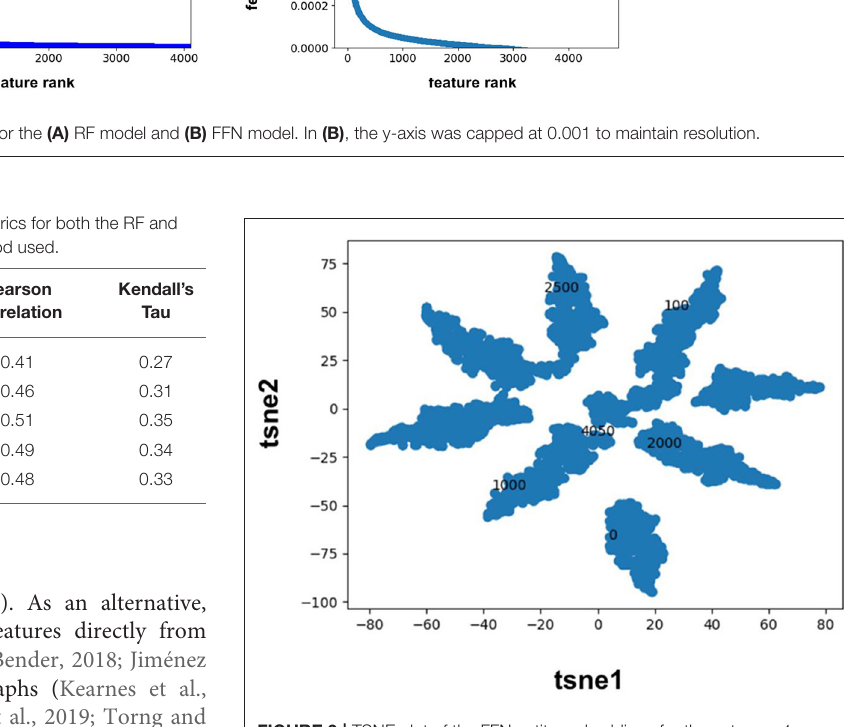
FIGURE 3 | TSNE plot of the FFN entity embeddings for the category 1 variables of the morgan fingerprint vector. Category 1 was selected for plotting as this denotes the presence of a chemical fragment. The category 1 weights of the 0, 100, 1,000, 2,000, 2,500, and 4,050 bits are plotted in black to illustrate how the FFN model groups bits into distinct